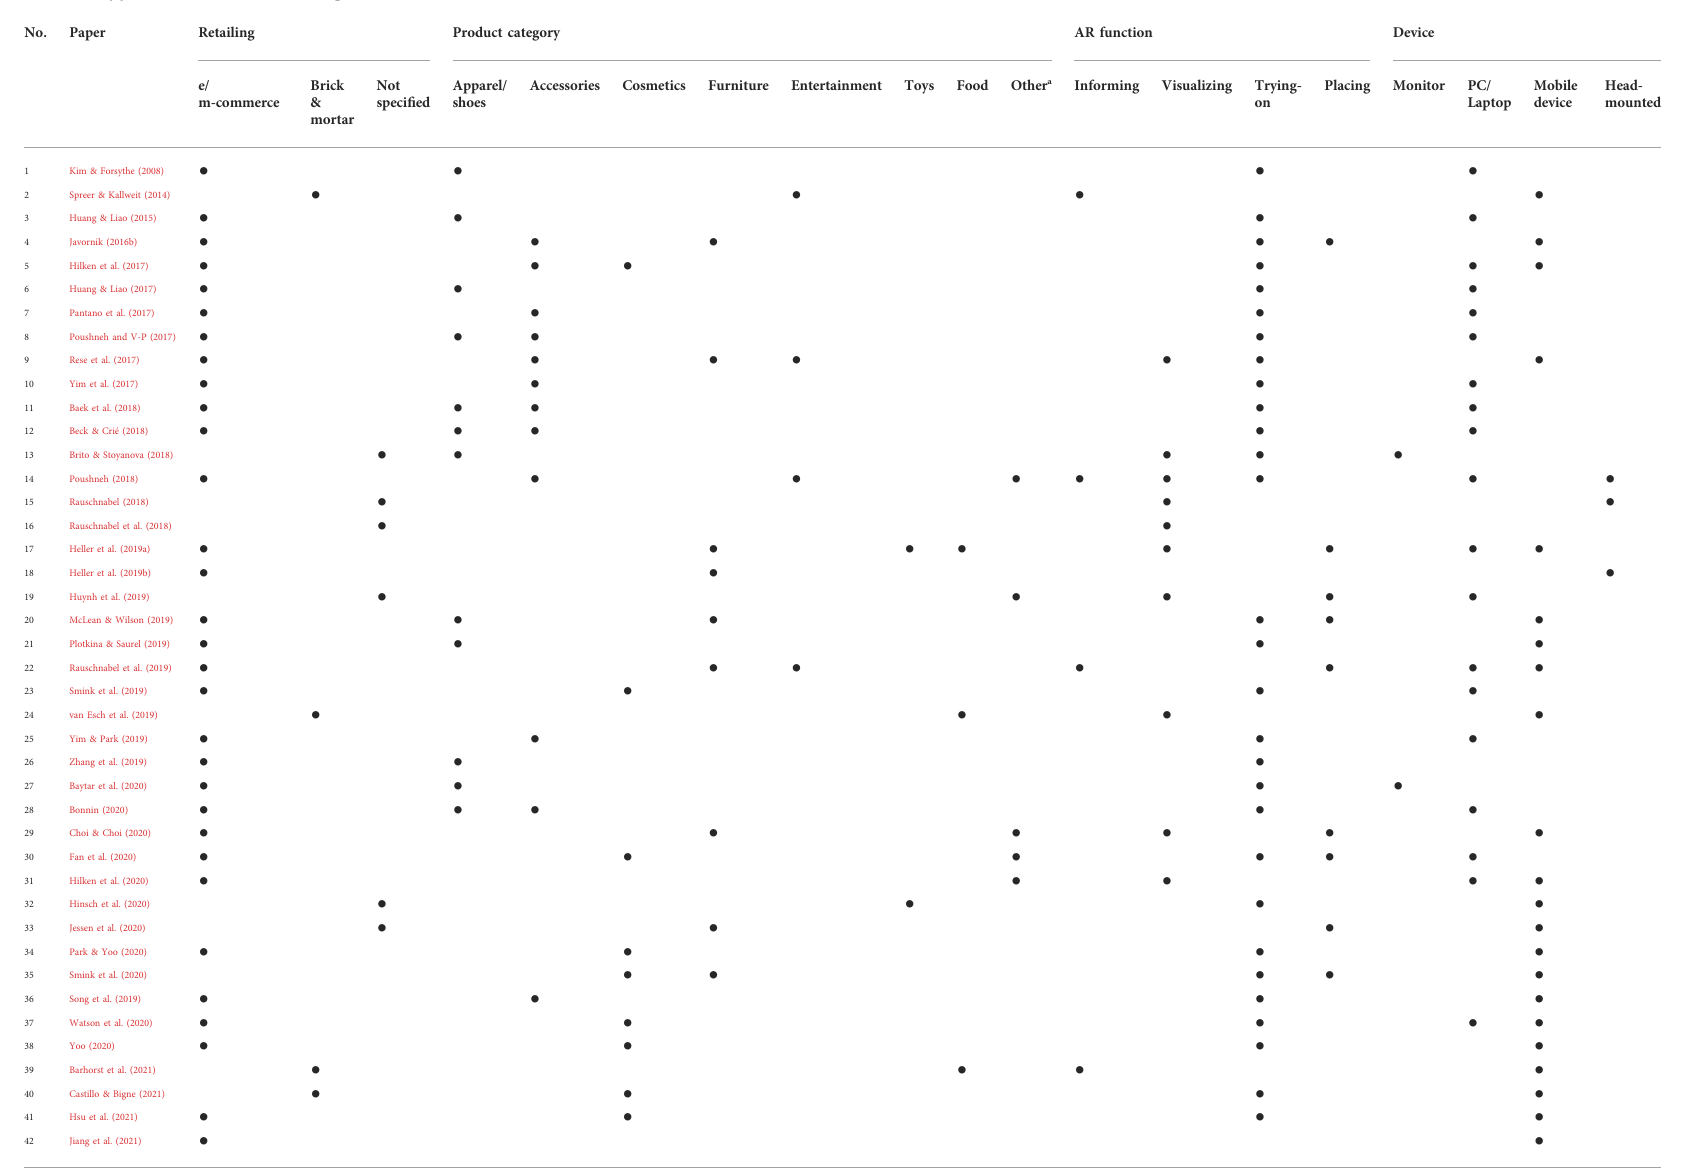
TABLE 2 Applications of AR in